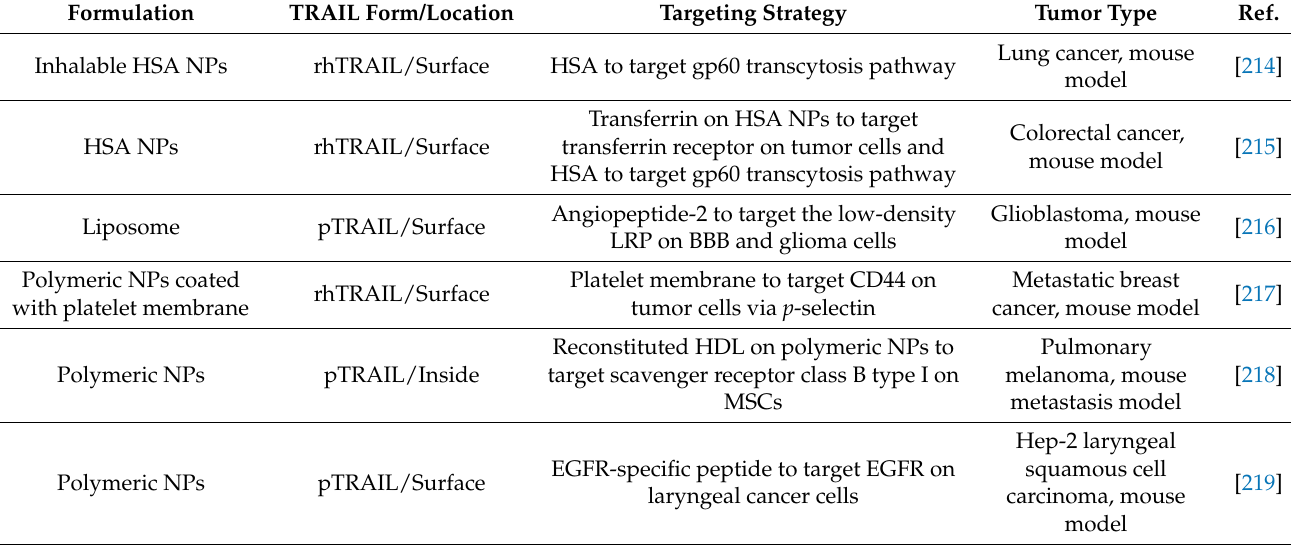
Table 2. Active targeting approaches for TRAIL